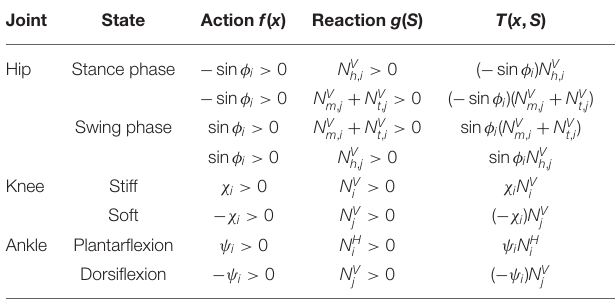
TABLE 1 | Design for Tegotae